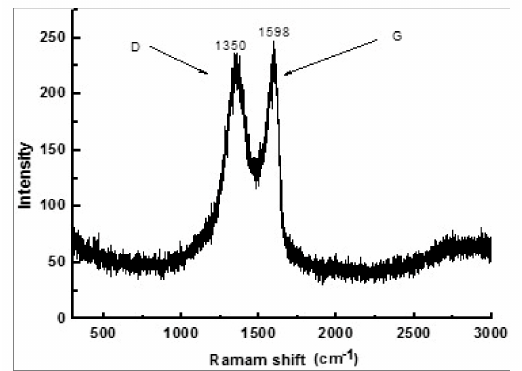
Figure 4. Raman spectrum of the GO-coated TiAl powders milled by the PVA-modified specimen.